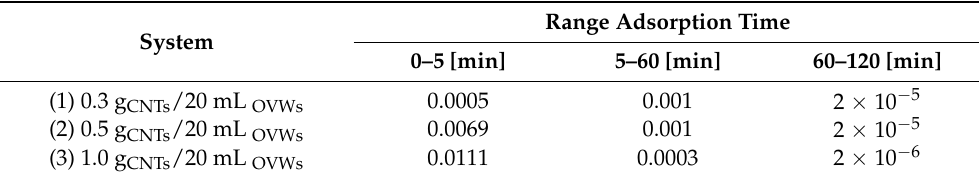
Table 3. Adsorption rate (g/min) in different time intervals for systems with different contents of carbon